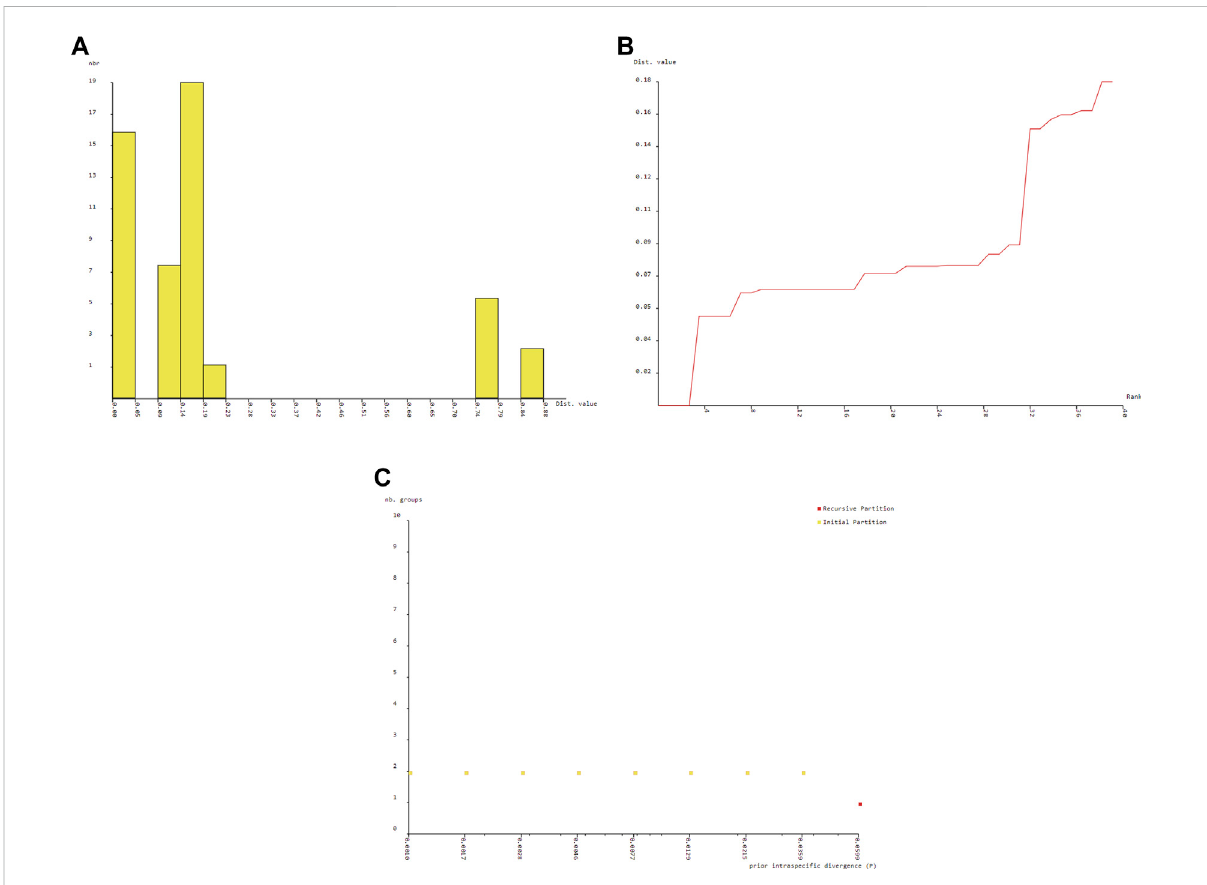
Barcode gap analysis of Pangasiid species generated by Automatic Barcode Discovery Gap Discovery (Puillandre et al., 2012). Distributions of K2P distances and between each pair of specimens (A) histogram of distance (B) ranked distance and (C) number of PSHs obtained for each prior intraspeci fi c